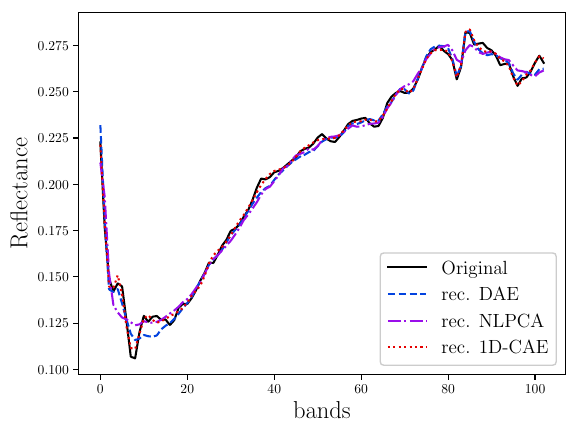
Figure 5. Comparison of the original spectrum of the factories roof with the reconstructions of the 1D-CAE, DAE and NLPCA. CAE and the other methods are the utilized layer